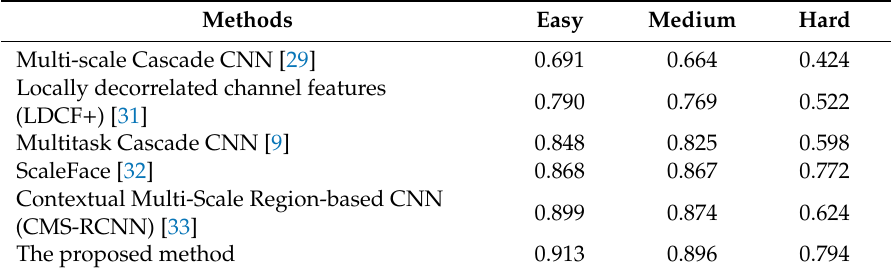
Table 5. AP comparison between the proposed method and typical face detection methods.